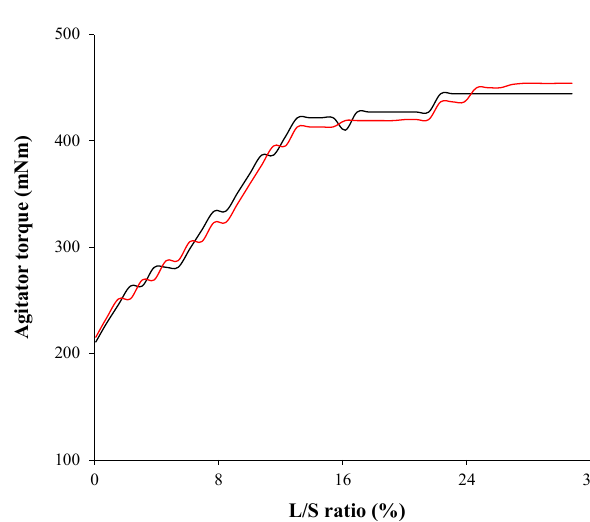
Figure 13. Agitator torque profiles at the lab scale (black line) and pilot scale (red line). The agitator powder consumption is plotted versus liquid / solid (L / S) ratio (%).